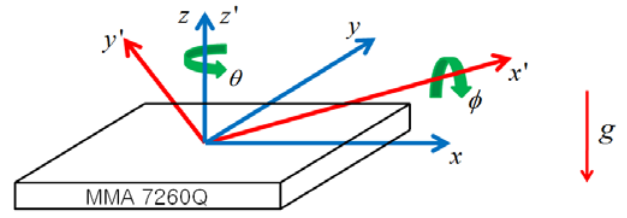
Figure 5. Rotation and force of an acceleration